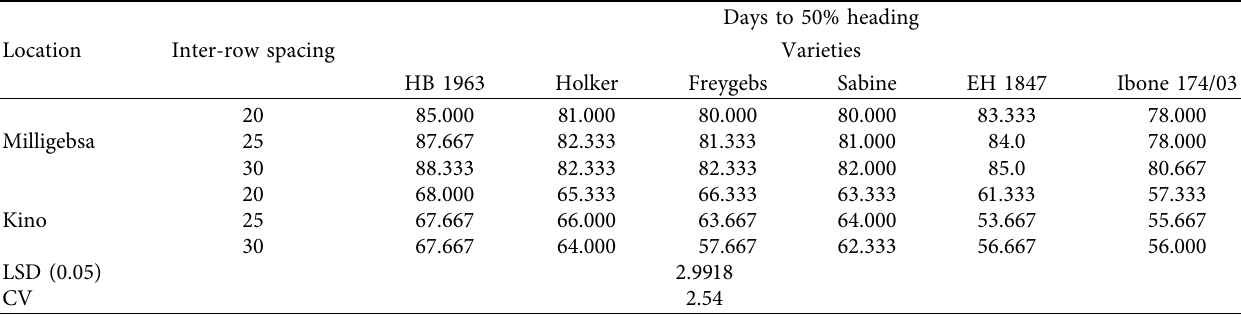
Table 2: Interaction effect of varieties, inter-row spacing, and location on days to 50% heading of malt barley at Debark, north Gondar, Ethiopia, in